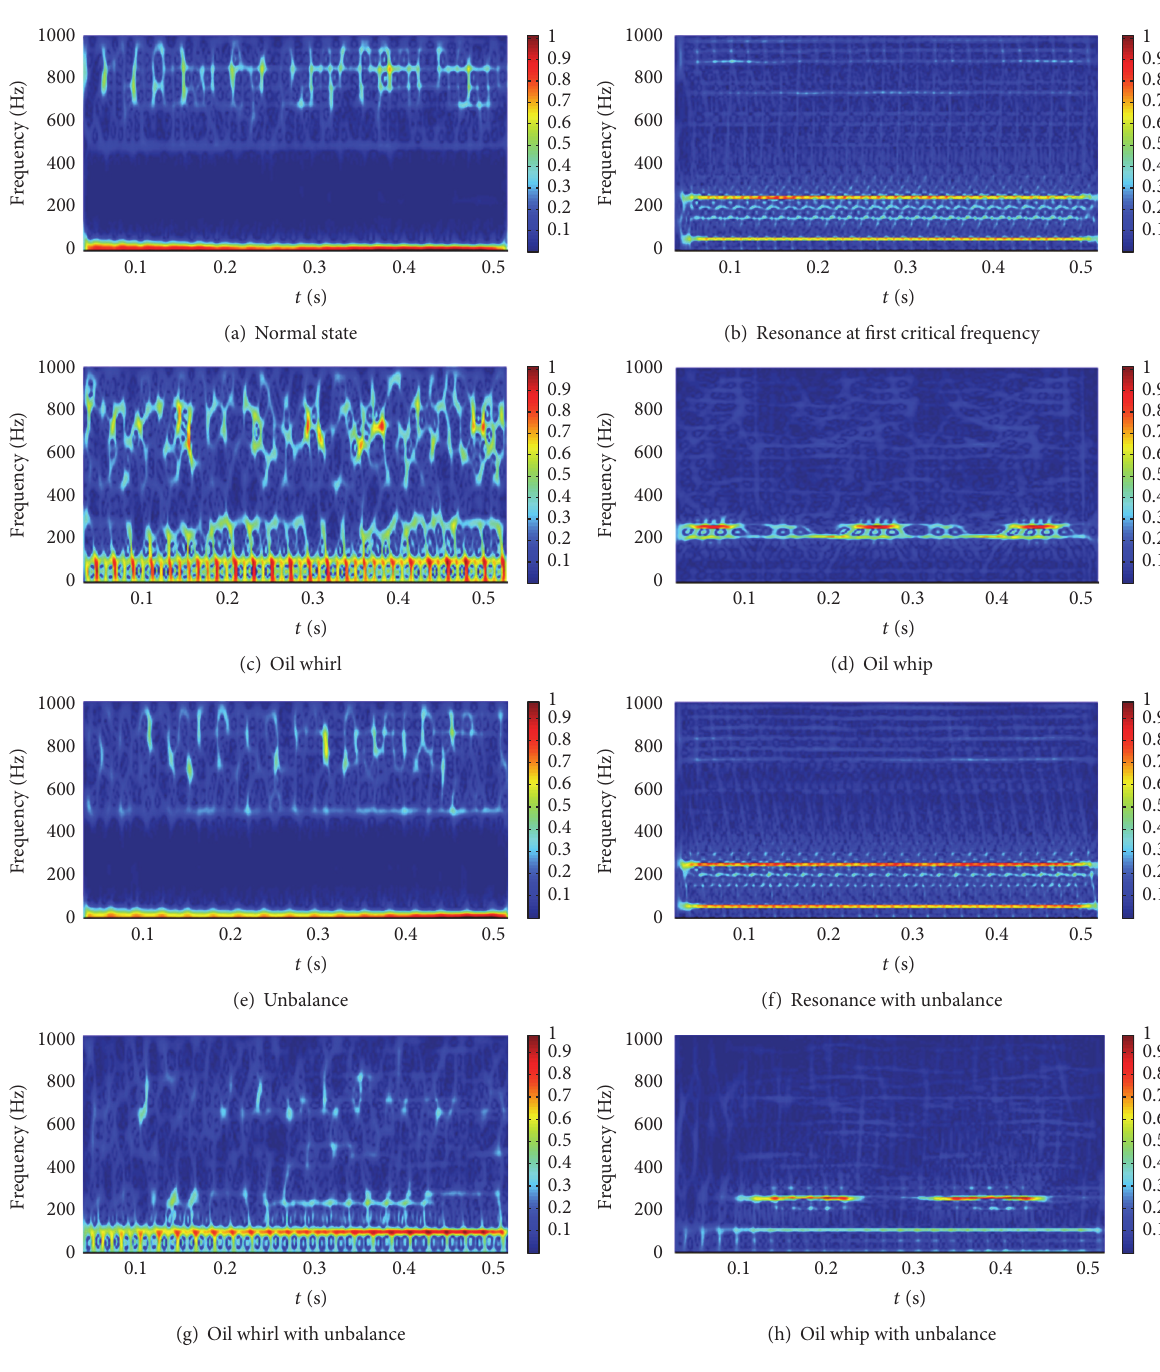
Figure 2: AOK time-frequency spectrogram for each sample